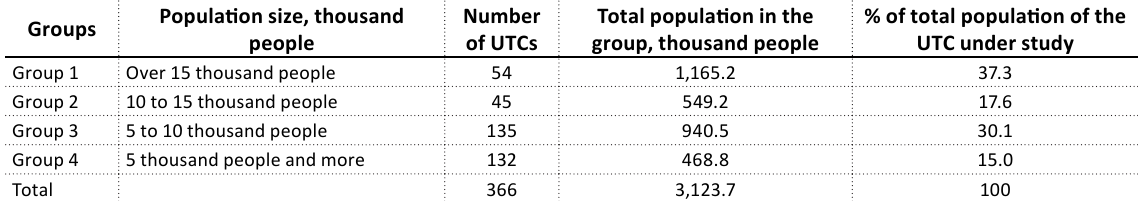
Table 4. UTC distribution by population in 2017